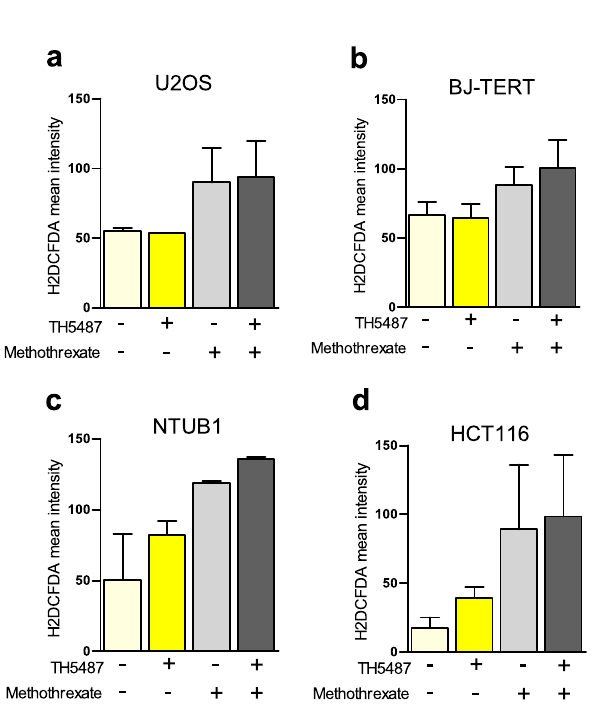
Figure 4. Intracellular ROS formation. ( A ) Intracellular ROS (H2DCFDA mean intensity) generated after 72 h of exposure to methotrexate (10 µM), alone or in combination with TH5487 (10 µM) in U2OS cells, ( B ) BJ-TERT, ( C ) NTUB1 or ( D ) HCT116 cells. 10 µM of TH5487 were used in combination with methotrexate for all the cell lines, except for NTUB1 where 5 µM of TH5487 were used. Data are average and SEM of